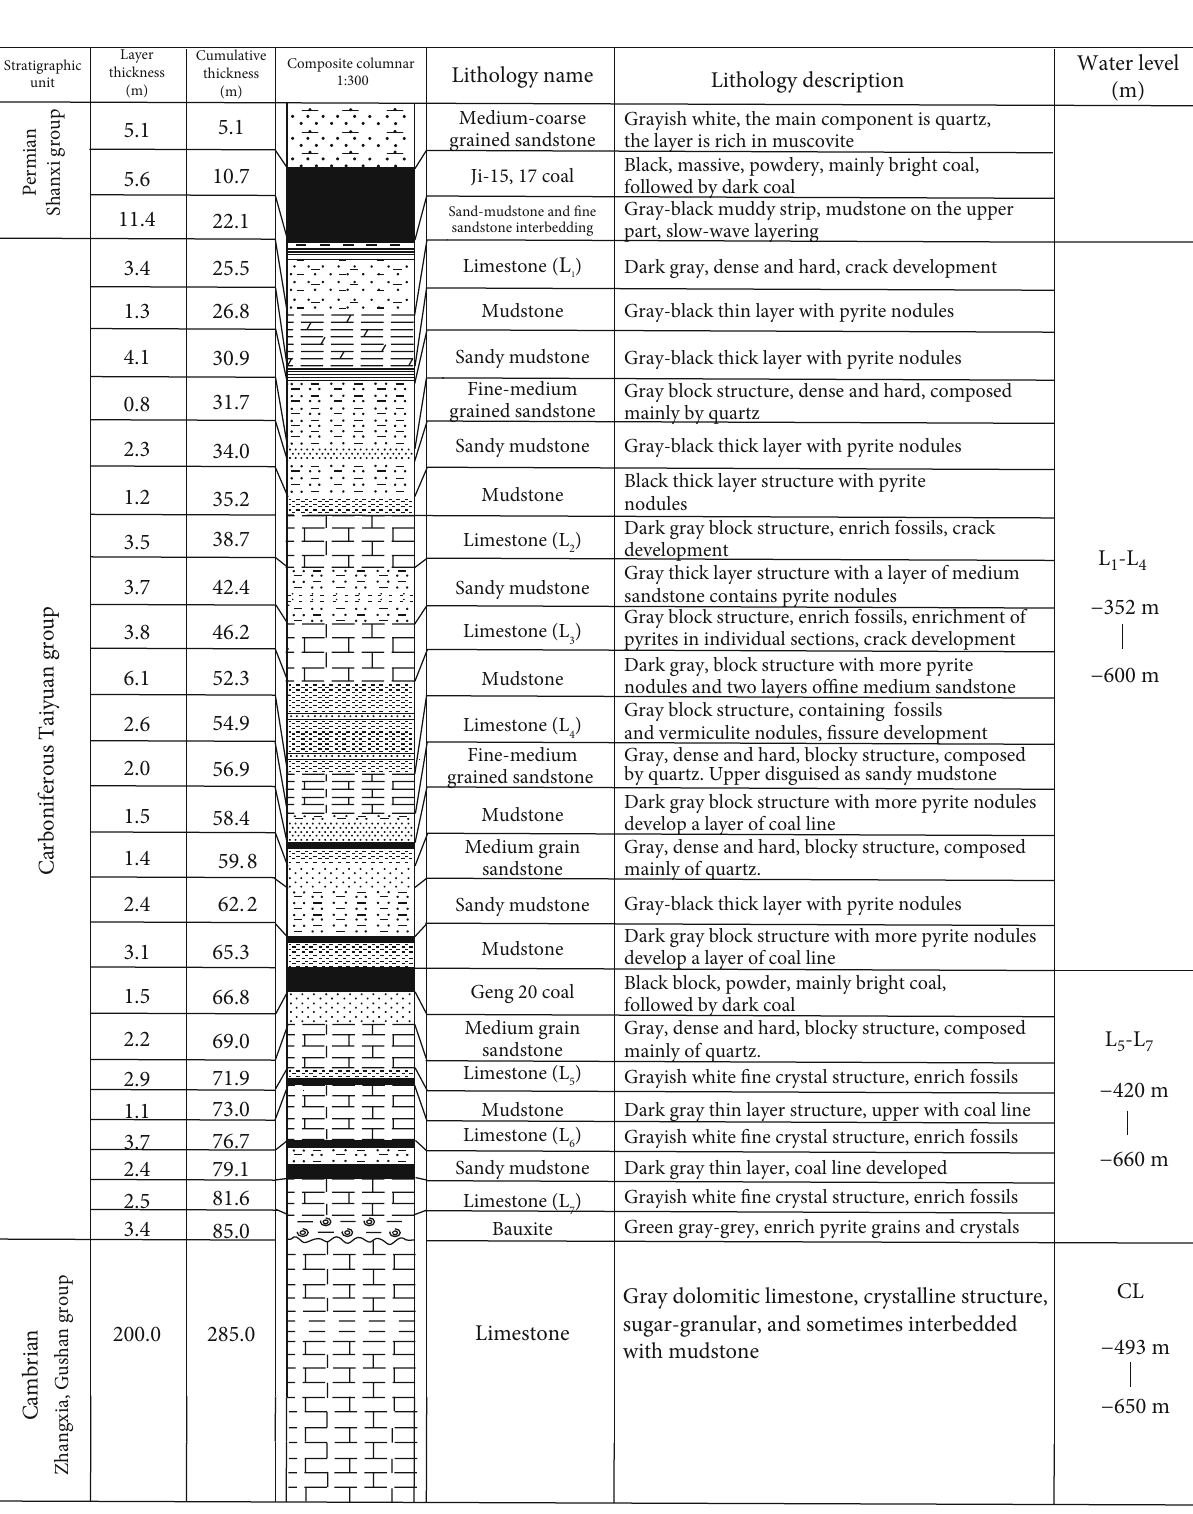
Gray, dense and hard, blocky structure, composed mainly of quartz.